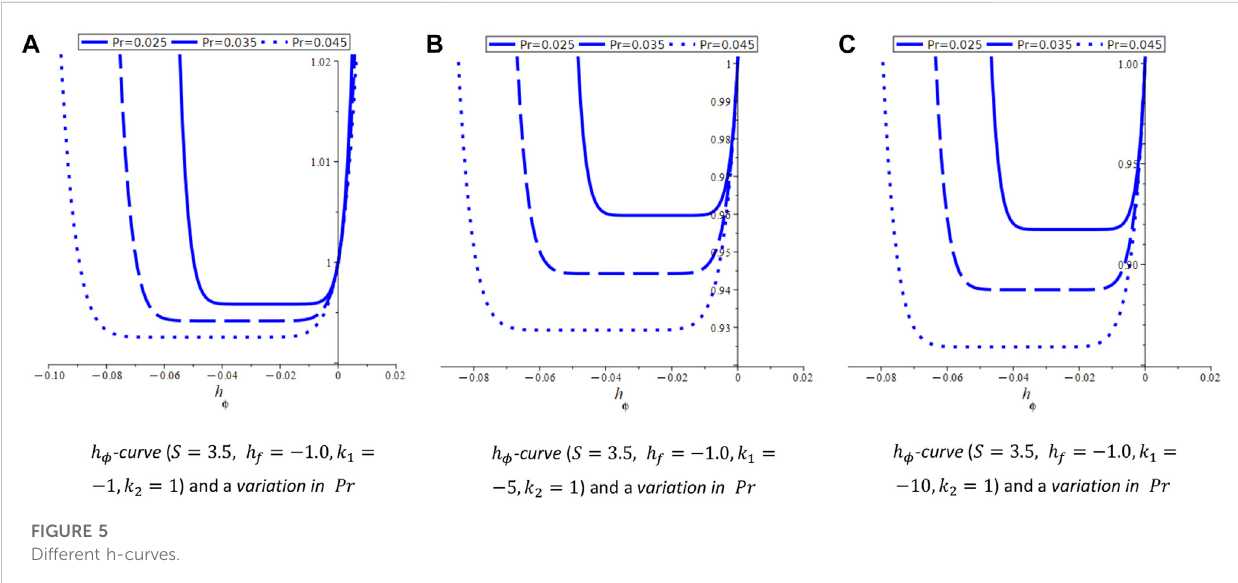
FIGURE 5 Different